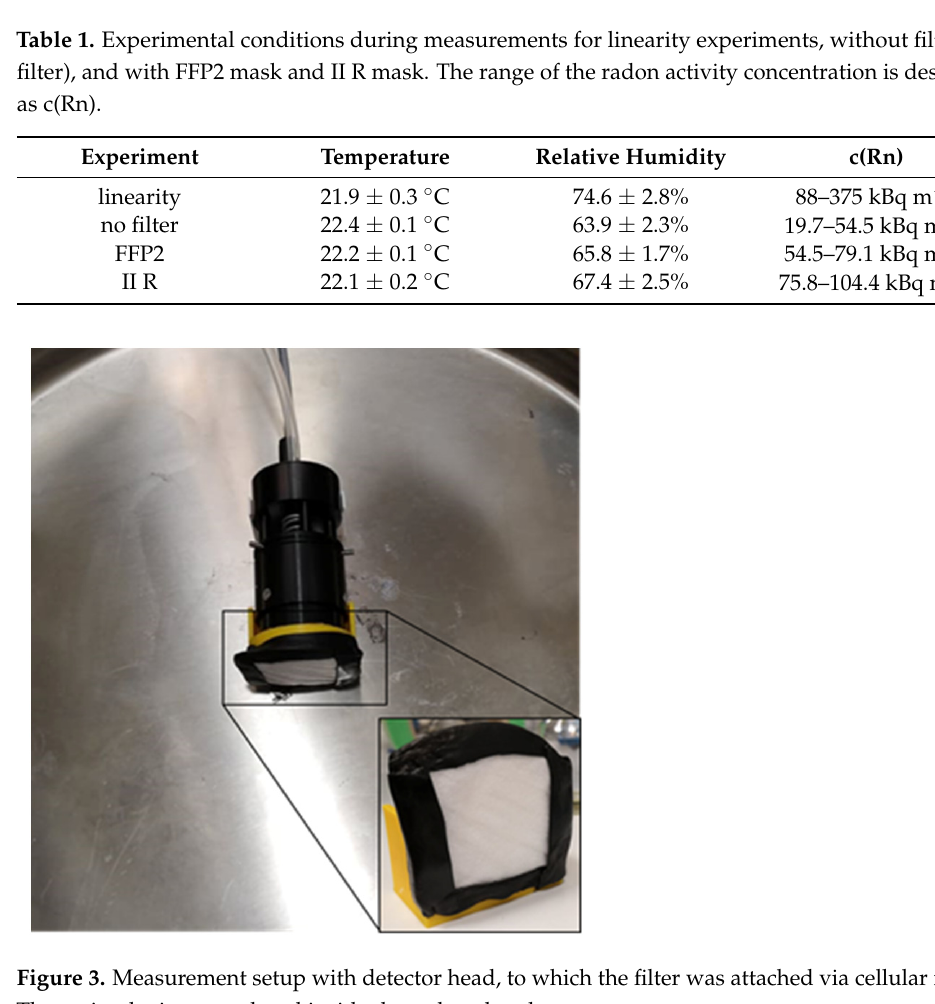
Figure 3. Measurement setup with detector head, to which the filter was attached via cellular rubber. The entire device was placed inside the radon chamber.